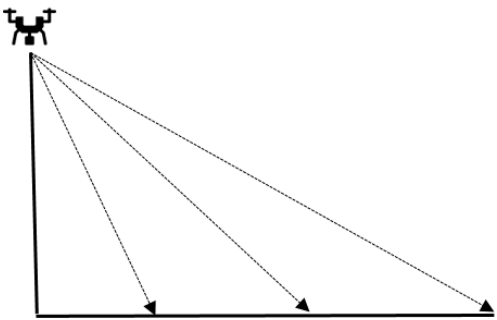
Figure 2. Schematic diagram of the point count survey method modified from Bushaw [34].